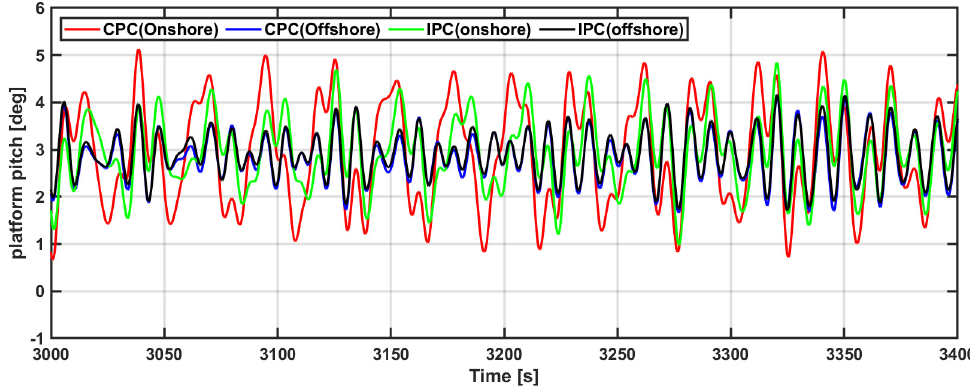
Figure 9. Platform pitch movement of floating offshore wind turbine based on pitch controller.